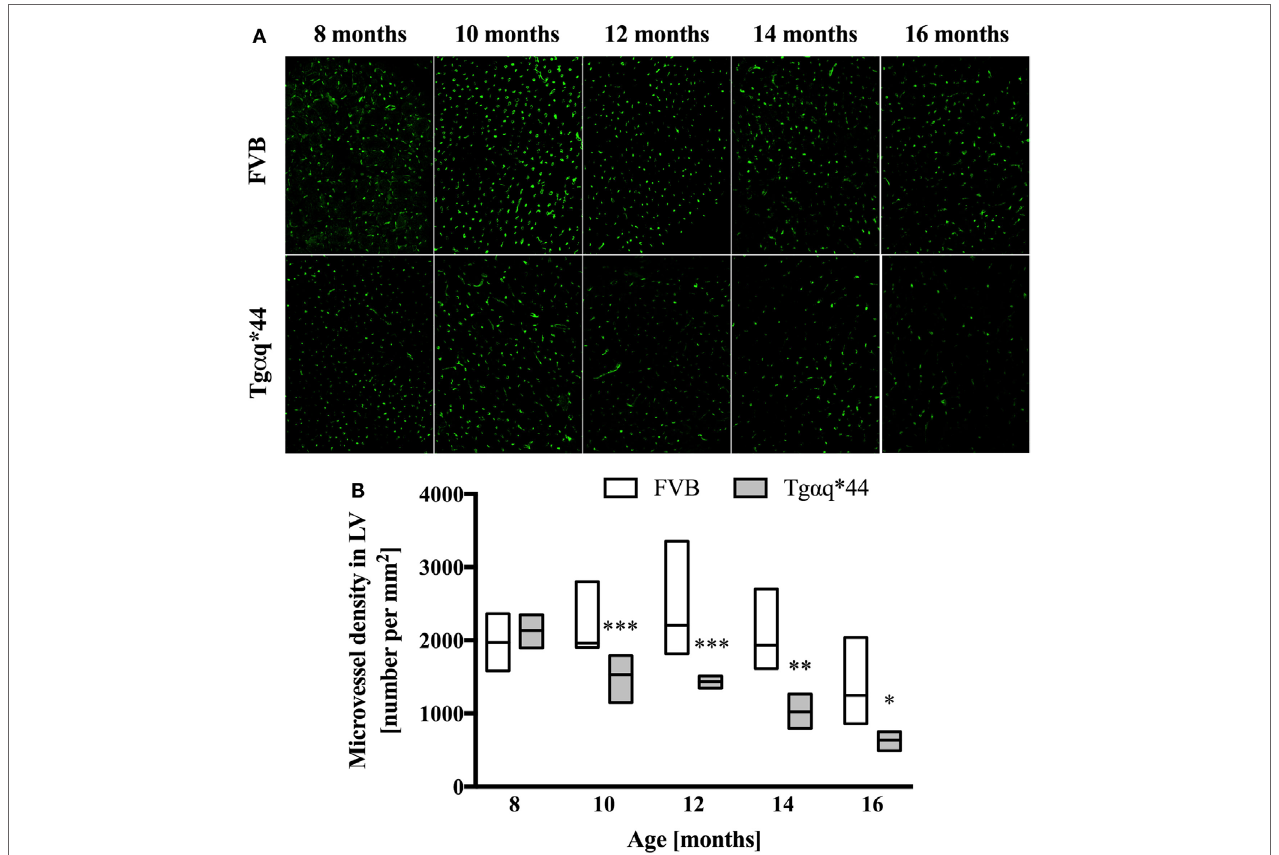
FigUre 5 | Microvessel density in the heart of Tg α q*44 and FVB mice. (a) Representative images of microvessels in the left ventricle stained using lectin from 8- to 16-month-old Tg α q*44 and FVB mice. (B) The number of microvessels per square millimeters, quantified using automated morphological manipulations of images on the thresholded FITC channel, as described in Section “Materials and Methods.” Data shown as median ± IQR. Statistical significance was assessed using two-way ANOVA, with post hoc LSD’s test between groups. * P < 0.05, ** P < 0.01, and *** P < 0.005 denote significant differences in aged-matched groups. Furthermore, one-way ANOVA within Tg α q*44 mice showed a strong linear trend ( P < 0.001) for decrease in microvessel density. n = 4–9 slices per